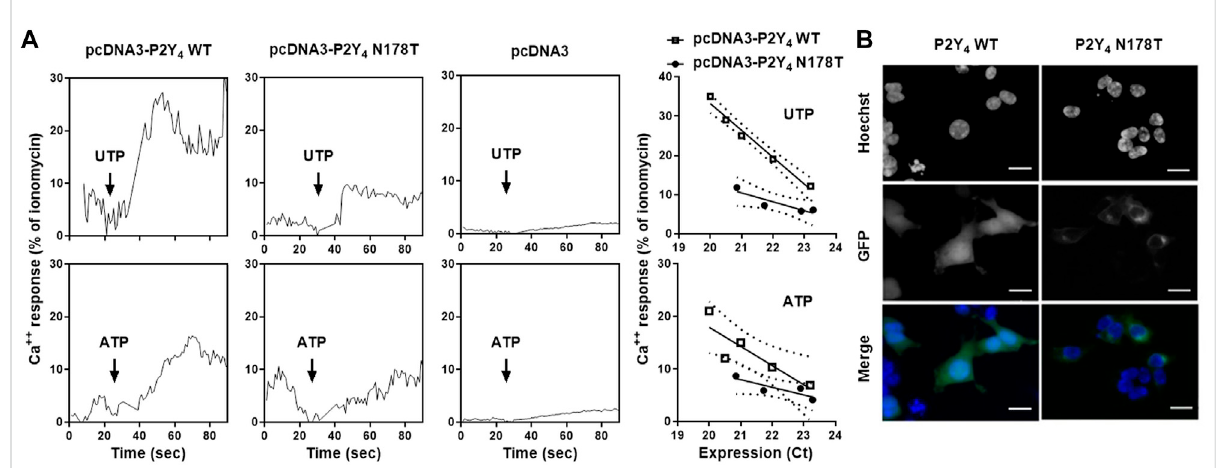
FIGURE 3 N178T polymorphism is a loss-of-function mutation for the human P2Y 4 receptor. (A) Reduced UTP and ATP responses in 1321N1 cells expressing the N178T P2Y 4 mutant. The calcium responses to 100 µM UTP or 100 µM ATP were compared in 1321N1 cells expressing the WT P2Y 4 receptor or the N178T P2Y 4 receptor. Left graphs, UTP and ATP calcium response in a pool of 1321N1 cells transfected with pcDNA3-WT P2Y 4 or pcDNA3-N178T P2Y 4 , selected with G418 and displaying a comparable Ct value for P2Y 4 mRNA expression in qRT-PCR experiments. UTP and ATP calcium response was also tested in a pool of 1321N1 cells transfected with the pcDNA3 vector alone. Right graphs, UTP, and ATP calcium responsesinindividual1321N1transfectedclonesexpressingvariouslevels(expressedinCtvaluesfromqRT-PCRexperiments)ofWTorN178TP2Y 4 receptor. (B) Reduced fl uorescentsignalofGFP-taggedN178TP2Y 4 receptorscomparedtoGFP-taggedWTP2Y 4 receptorsintransfectedHEK-293 cells. Images were obtained using Zoe ™ Fluorescent Cell Imager (scale bar = 25